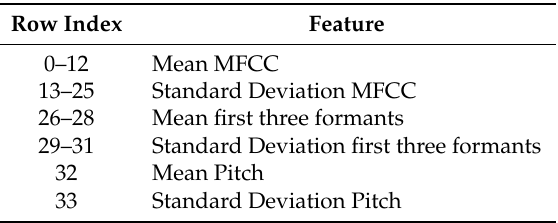
Table 2. Components of the feature